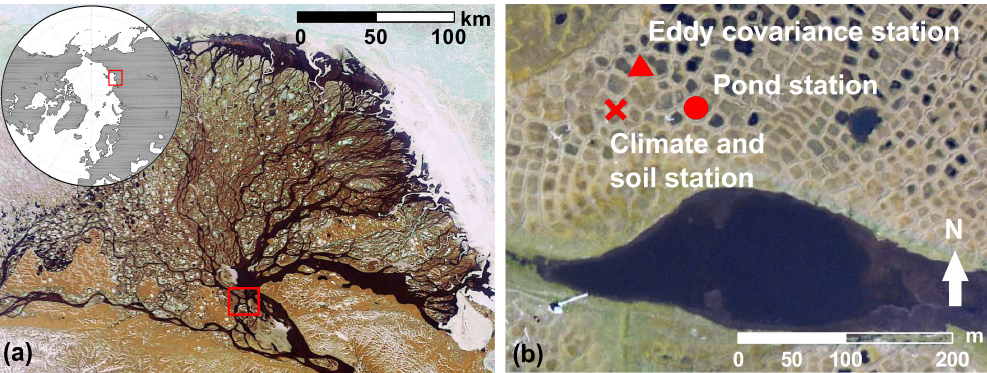
Fig. 1. (a) Location of the study site (72 ◦ 22 0 N; 126 ◦ 30 0 E) in the Lena River Delta on a Envisat (MERIS) image acquired on 15 June 2006 (ESA, 2006). (b) Location of the measurement stations at the study site on Samoylov